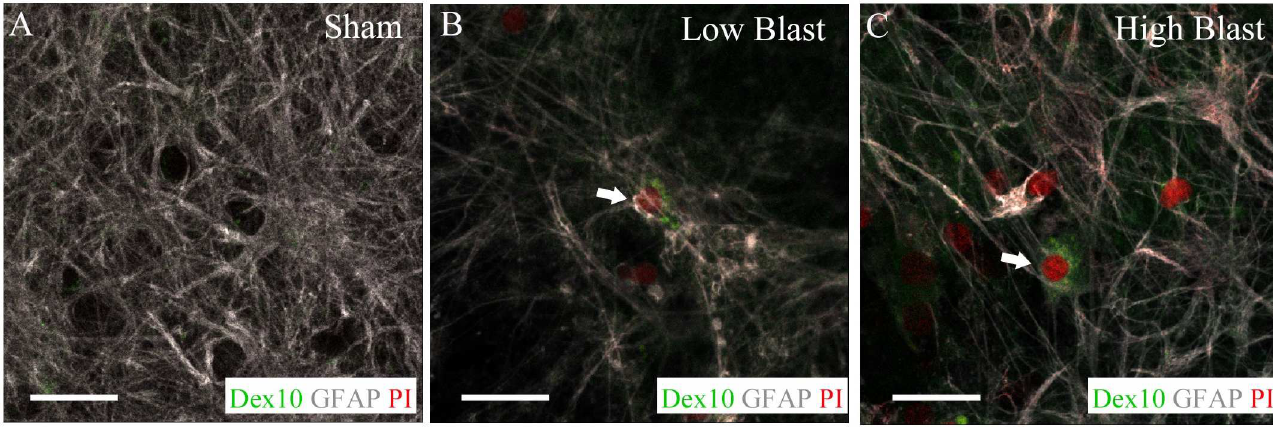
Fig 4. Increased astrocytic membranepermeability at 2 h post injury. Dex10 (green) and PI (red) labeledsham control (A), low-blast(B), or high- blast (C) OHCs were fixed 2 h followinginjury and further stained with an anti-GFAP antibody(gray). Dead astrocytes with increasedmembrane permeability, identifiedby overlap of GFAP, PI, and Dex10 staining(arrows), were only present in the low-blast(B) and high-blast (C) OHCs but not in the sham controls (A). Scale bars 20 μ